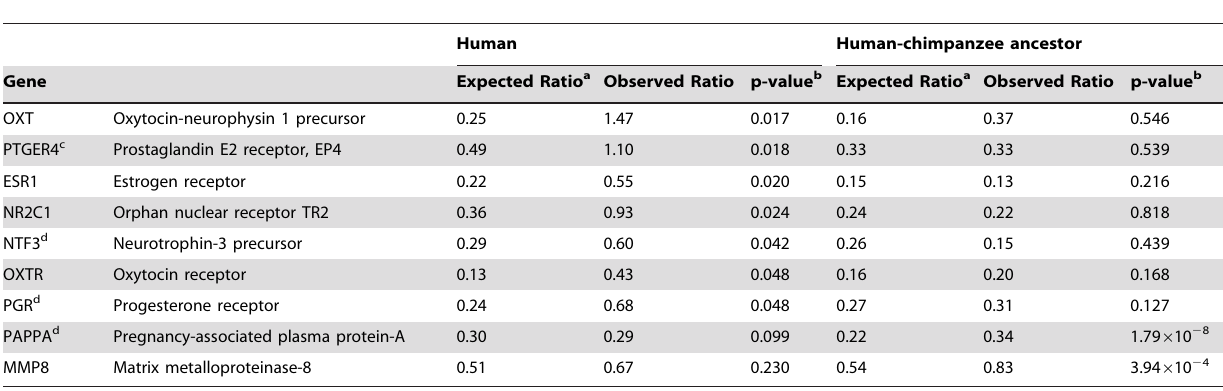
Table 1. Sample of candidate genes showing coding region rate acceleration in humans.